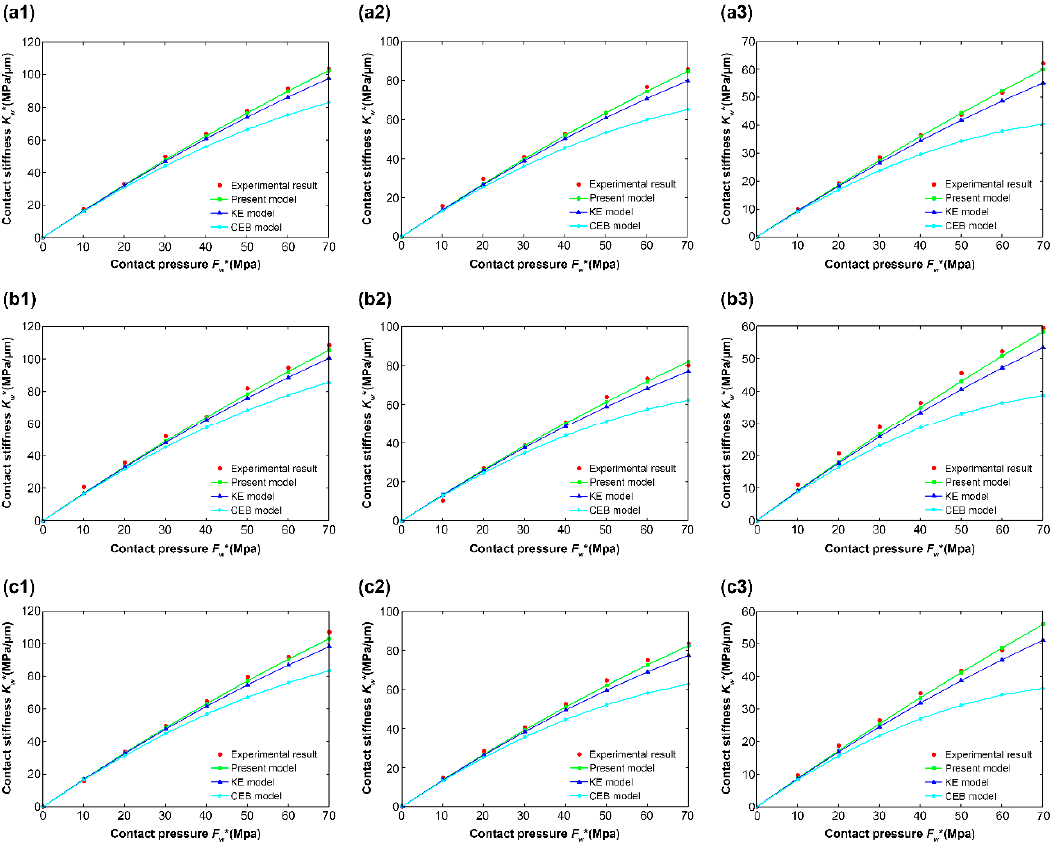
Figure 6. Comparison results of 45# steel for ( a1 ) 𝑆𝑎 0.122 μ m, ( a2 ) 𝑆𝑎 0.345 μ m, and ( a3 ) 𝑆𝑎 0.672 μ m. Comparison results of 40Cr steel for ( b1 ) 𝑆𝑎 0.122 μ m, ( b2 ) 𝑆𝑎 0.345 μ m, and ( b3 ) 𝑆𝑎 0.672 μ m. Comparison results of 304 stainless steel for ( c1 ) 𝑆𝑎 0.122 μ m, ( c2 ) 𝑆𝑎 0.345 μ m, and ( c3 ) 𝑆𝑎 0.672 μ m.